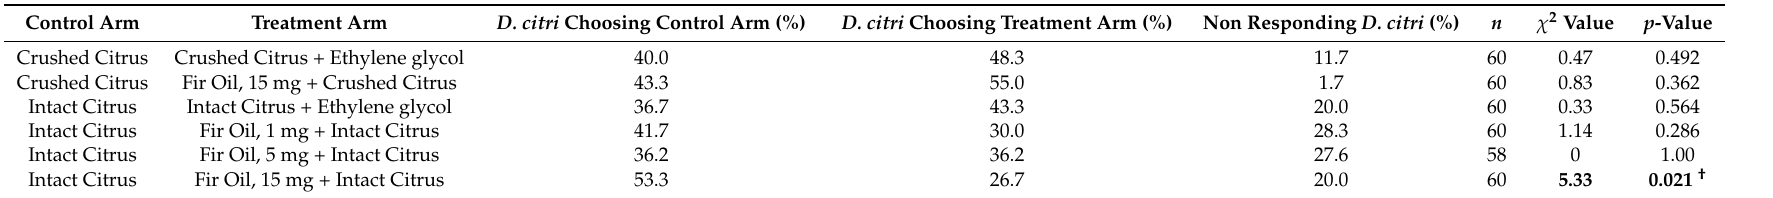
Table 2. Response of Diaphorina citri to fir oil treated citrus vs. untreated citrus in a T-olfactometer. To determine the degree of repellency of fir oil, female D. citri were challenged in a T-olfactometer. In the first experiment, odors from fir oil-treated crushed Valencia sour orange leaves were compared to odors from crushed citrus leaves. In the second experiment, odors from a fir oil-treated Valencia sour orange plants were compared to odors from an untreated citrus plants. The percentage of D. citri choosing each odor, as well as the percentage of non-responding D. citri , are listed in the table. The corresponding χ 2 values and p -values are listed a